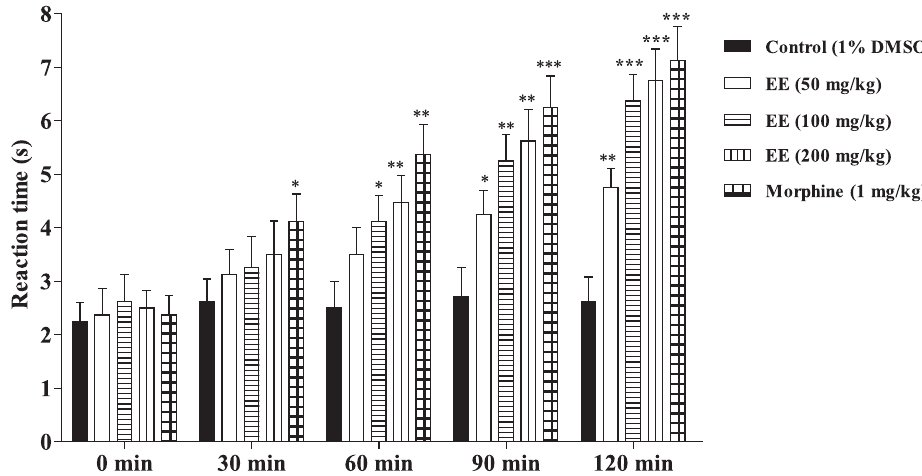
Figure 3 - Effects of the ethanol extract from A. fastigiatum branches on tail-immersion test in mice. EE, ethanol extract. Data are mean ± S.E.M. of 8 mice. * p < 0.05; ** p < 0.01; *** p < 0.001 vs control